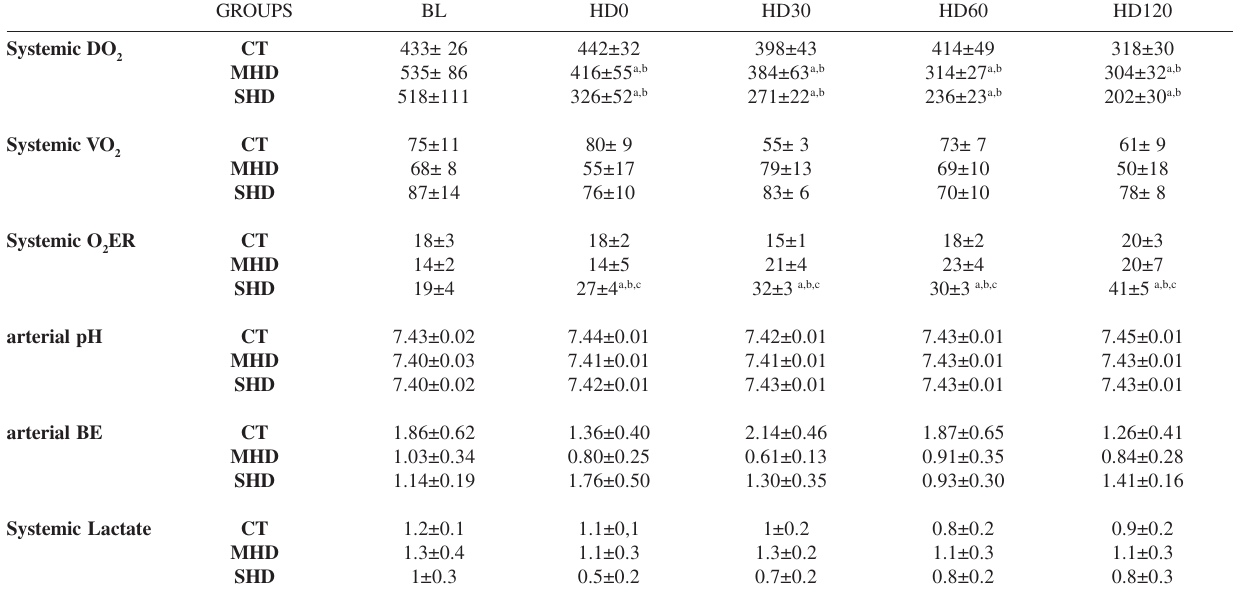
, VO and O ER, respectively) and arterial pH, base 2 2 2